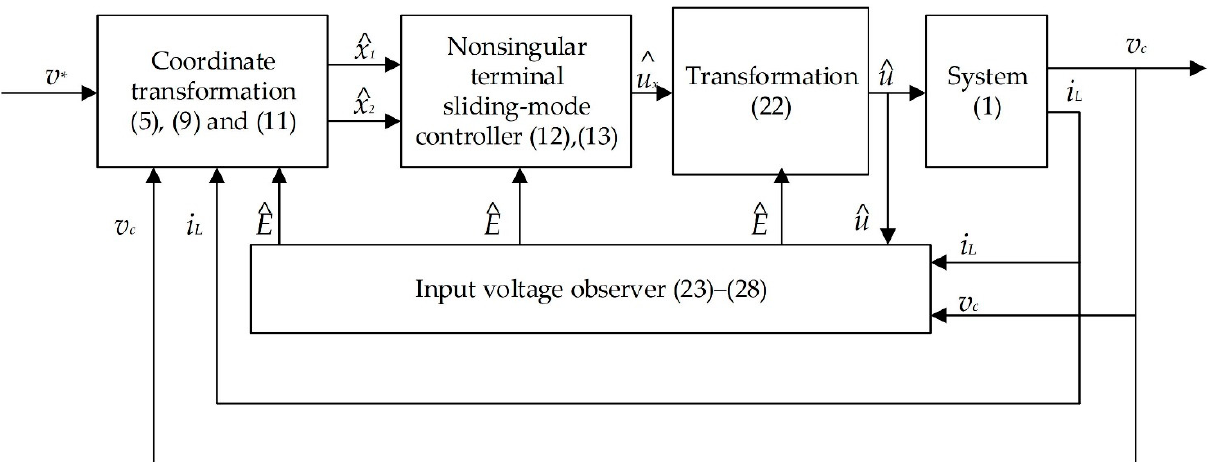
Figure 2. The structure of the proposed controller.